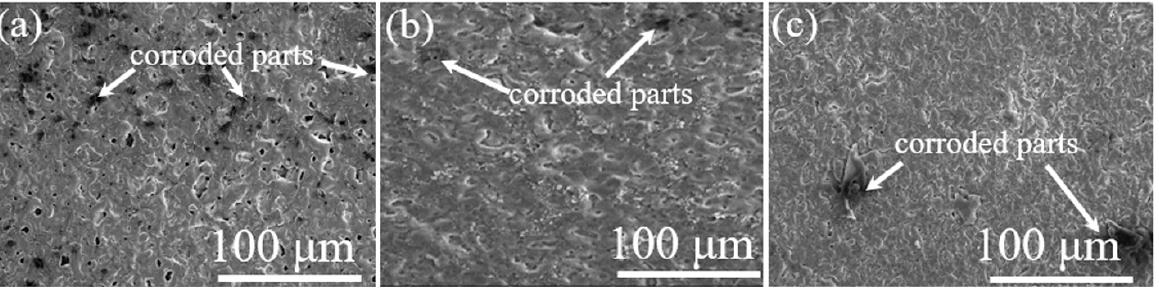
Figure 5. SEM images of the S0, S5, and S10 samples after electrochemical measurements. ( a ) S0 sample, ( b ) S5 sample, and ( c ) S10 sample.